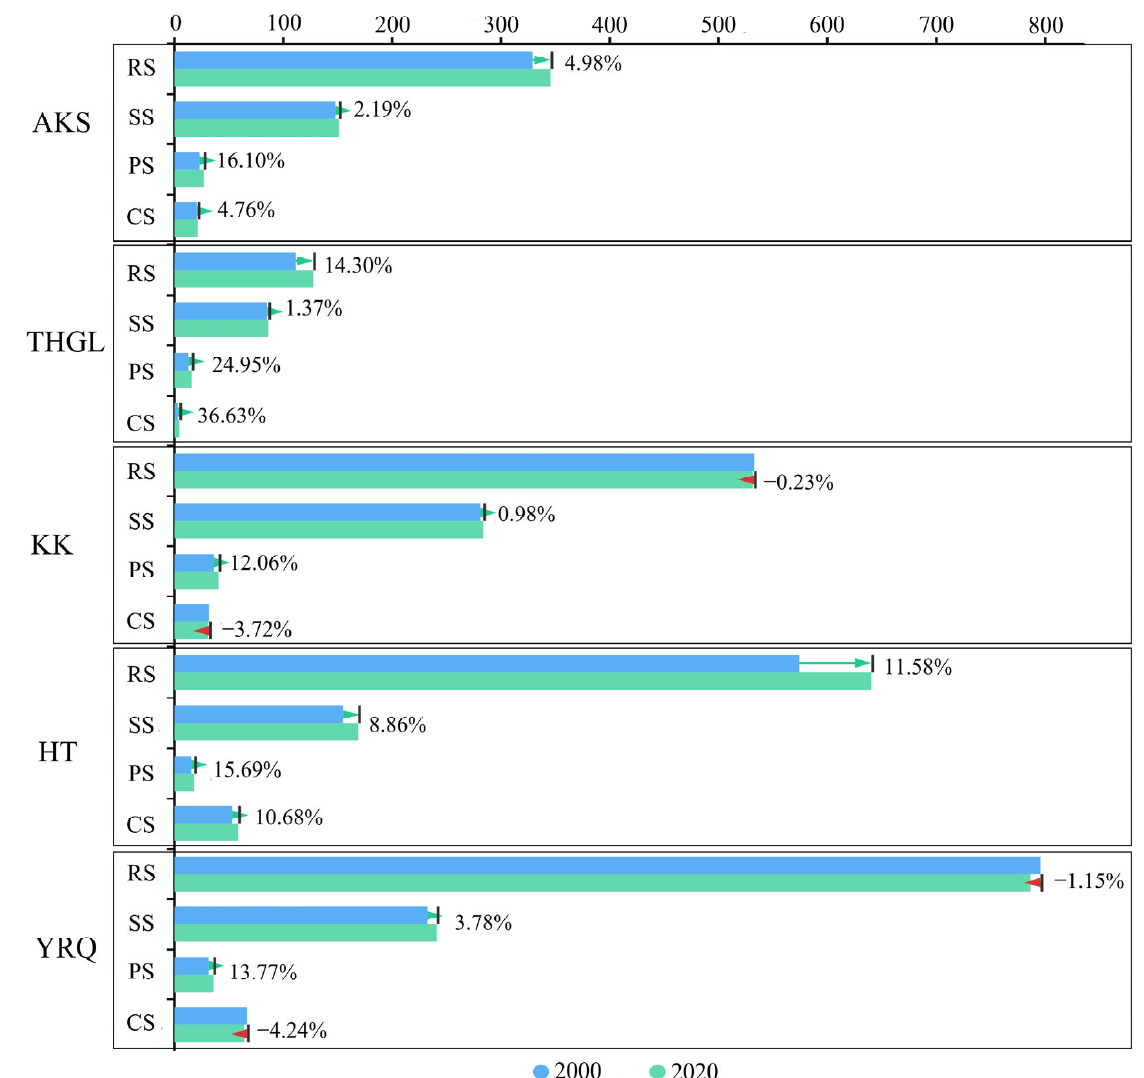
Figure 2. Variations in ESV for each sub-basin of the TRB (RS: Regulation Service; SS: Support Ser ‐ vice; PS: Provision Service, CS: Cultural Service) .